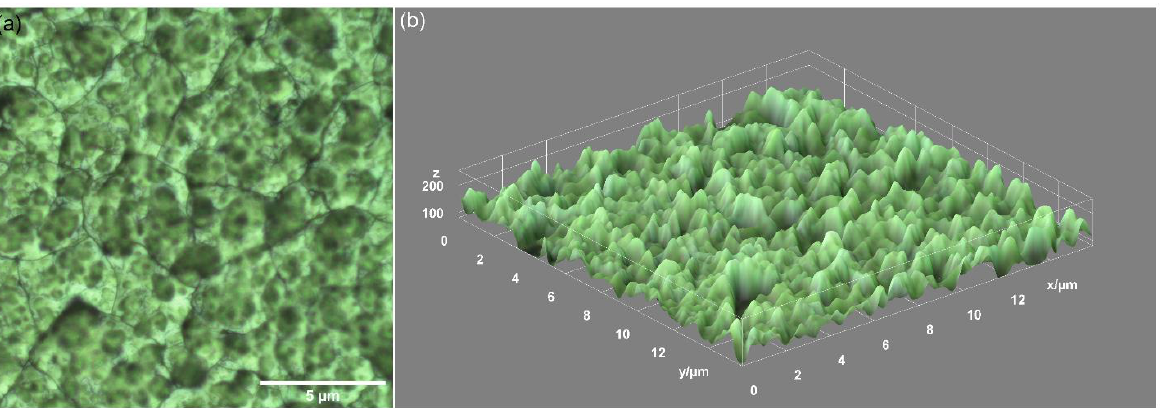
Figure 1. Optical image of DIO-NPs layers acquired with 40X objective ( a ) and 3D representation of the surface of the DIO-NPs layers ( b ).